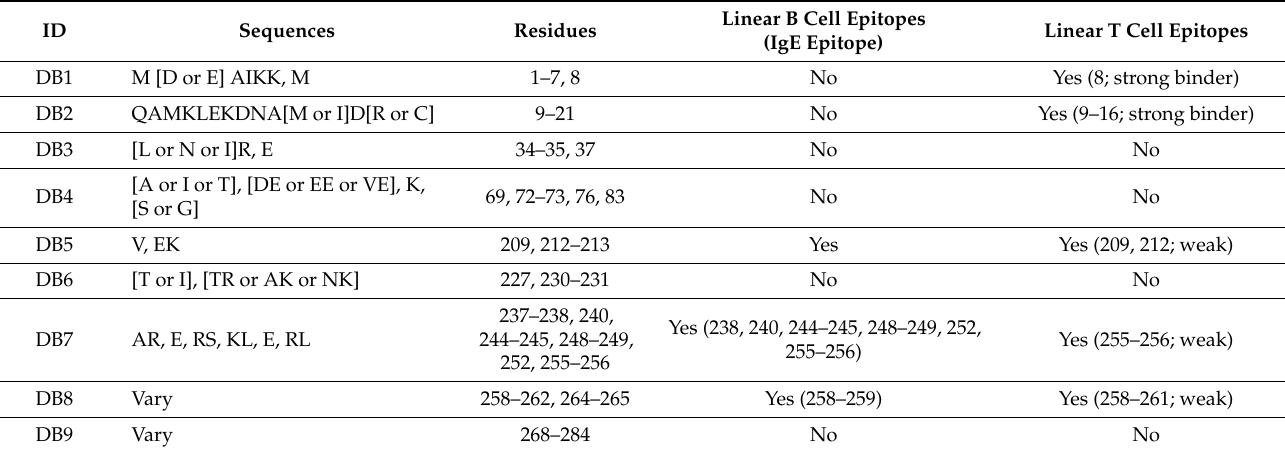
Table 5. Consensus discontinuous B cell epitopes identified by